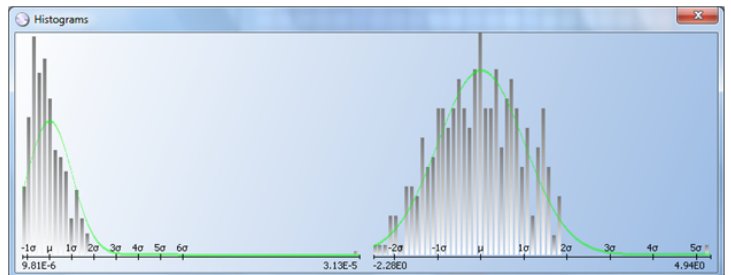
Figure 12. Exponential to normal distribution